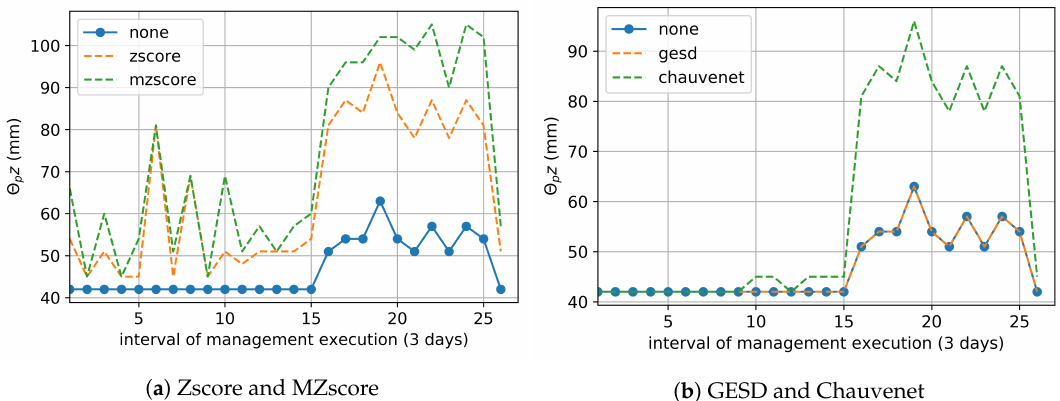
Figure 8. Predicted Moisture Data used in Water Balance—the points outside of the dashed lines are soil moisture data θ c modified by an outlier removal technique.